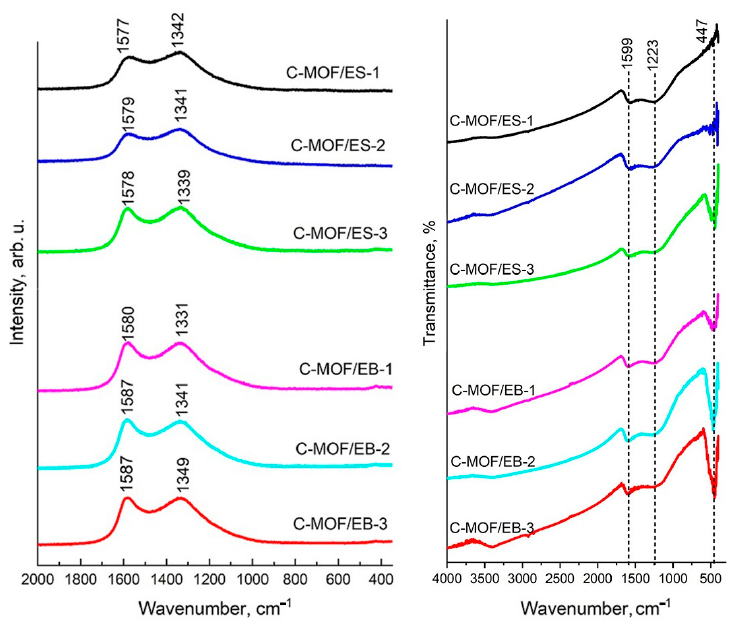
Figure 6. Raman spectra ( left ) and FTIR spectra ( right ) of C-(MOF-5/PANI)